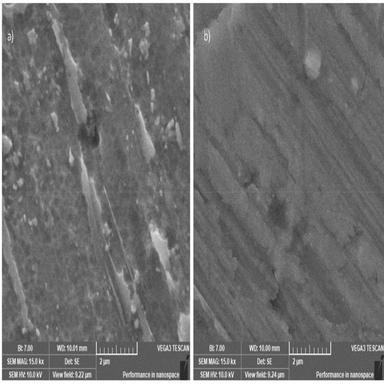
SEM images a) before corrosion. b) after corrosion.